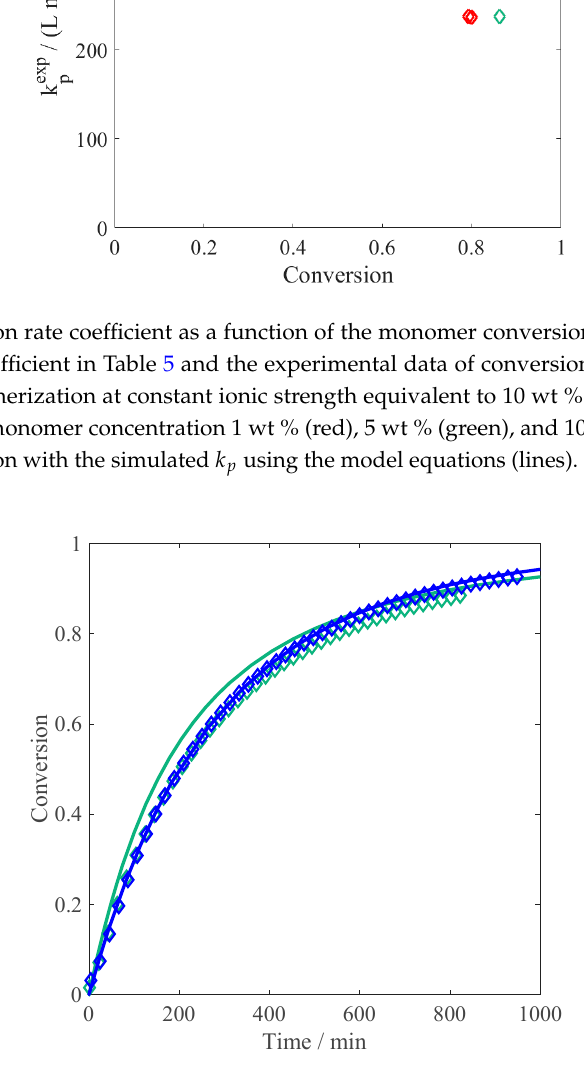
Figure 9. Monomer conversion versus time profiles of the radical batch polymerization of fully ionized MAA in aqueous solution at 50 °C, 0.1 wt % of V ‐ 50 initiator, and initial monomer concentration equal to 5 wt % (green) and 10 wt % (blue): comparison between experimental data by in ‐ situ NMR (diamonds) and simulated curves (lines, using the parameter values of Table 6).